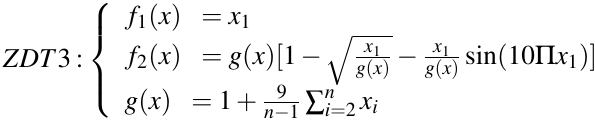
Fig. 5. Tradeoff points with HMH technique on ZDT1